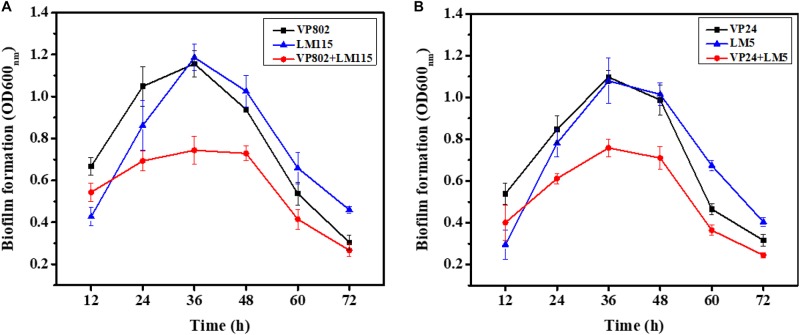
Mono- and mixed-species biofilms formation after 12, 24, 36, 48, 60, and 72 h incubation using CV assay. (A) Mono-, mixed-species biofilms formed by Vibrio parahaemolyticus VP802 and Listeria monocytogenes LM115; (B) mono-, mixed-species biofilm formed by V. parahaemolyticus VP24 and L. monocytogenes LM5. The black square, blue triangle represent mono-species biofilm formed by V. parahaemolyticus and L. monocytogenes, respectively. The red circle represents mixed-species biofilms formed by V. parahaemolyticus and L. monocytogenes. Error bars represent the standard deviation of triplicate experiments.